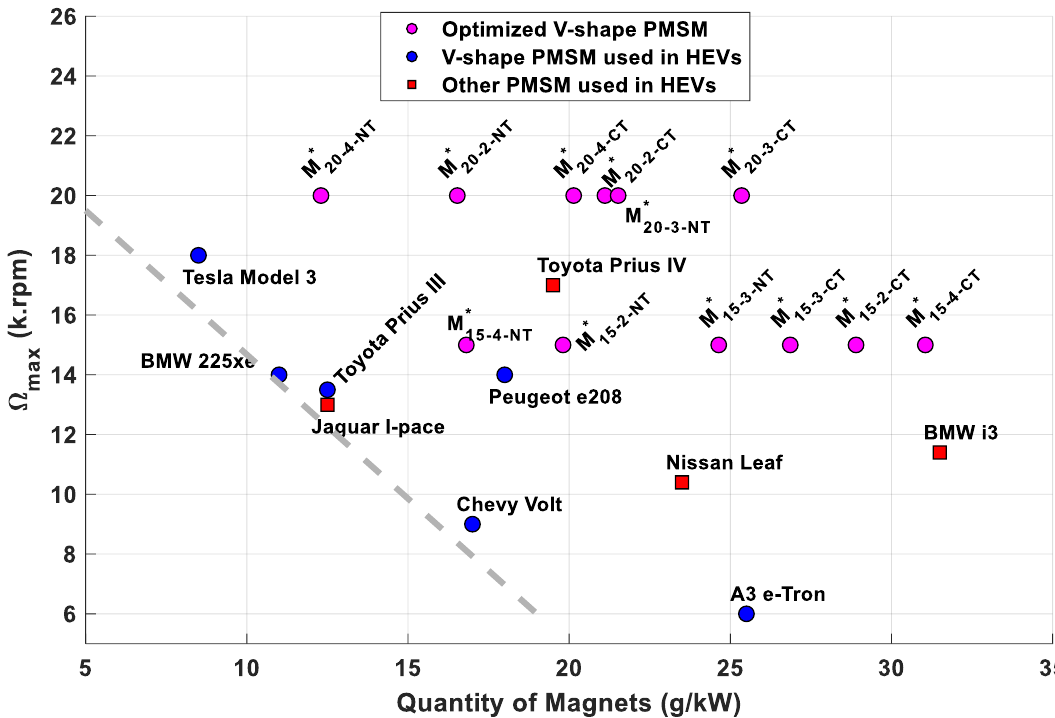
Figure 18. Maximum rotational speed vs. quantity of magnets per power for optimal machines and other machines used in hybrid electric vehicles (HEV).